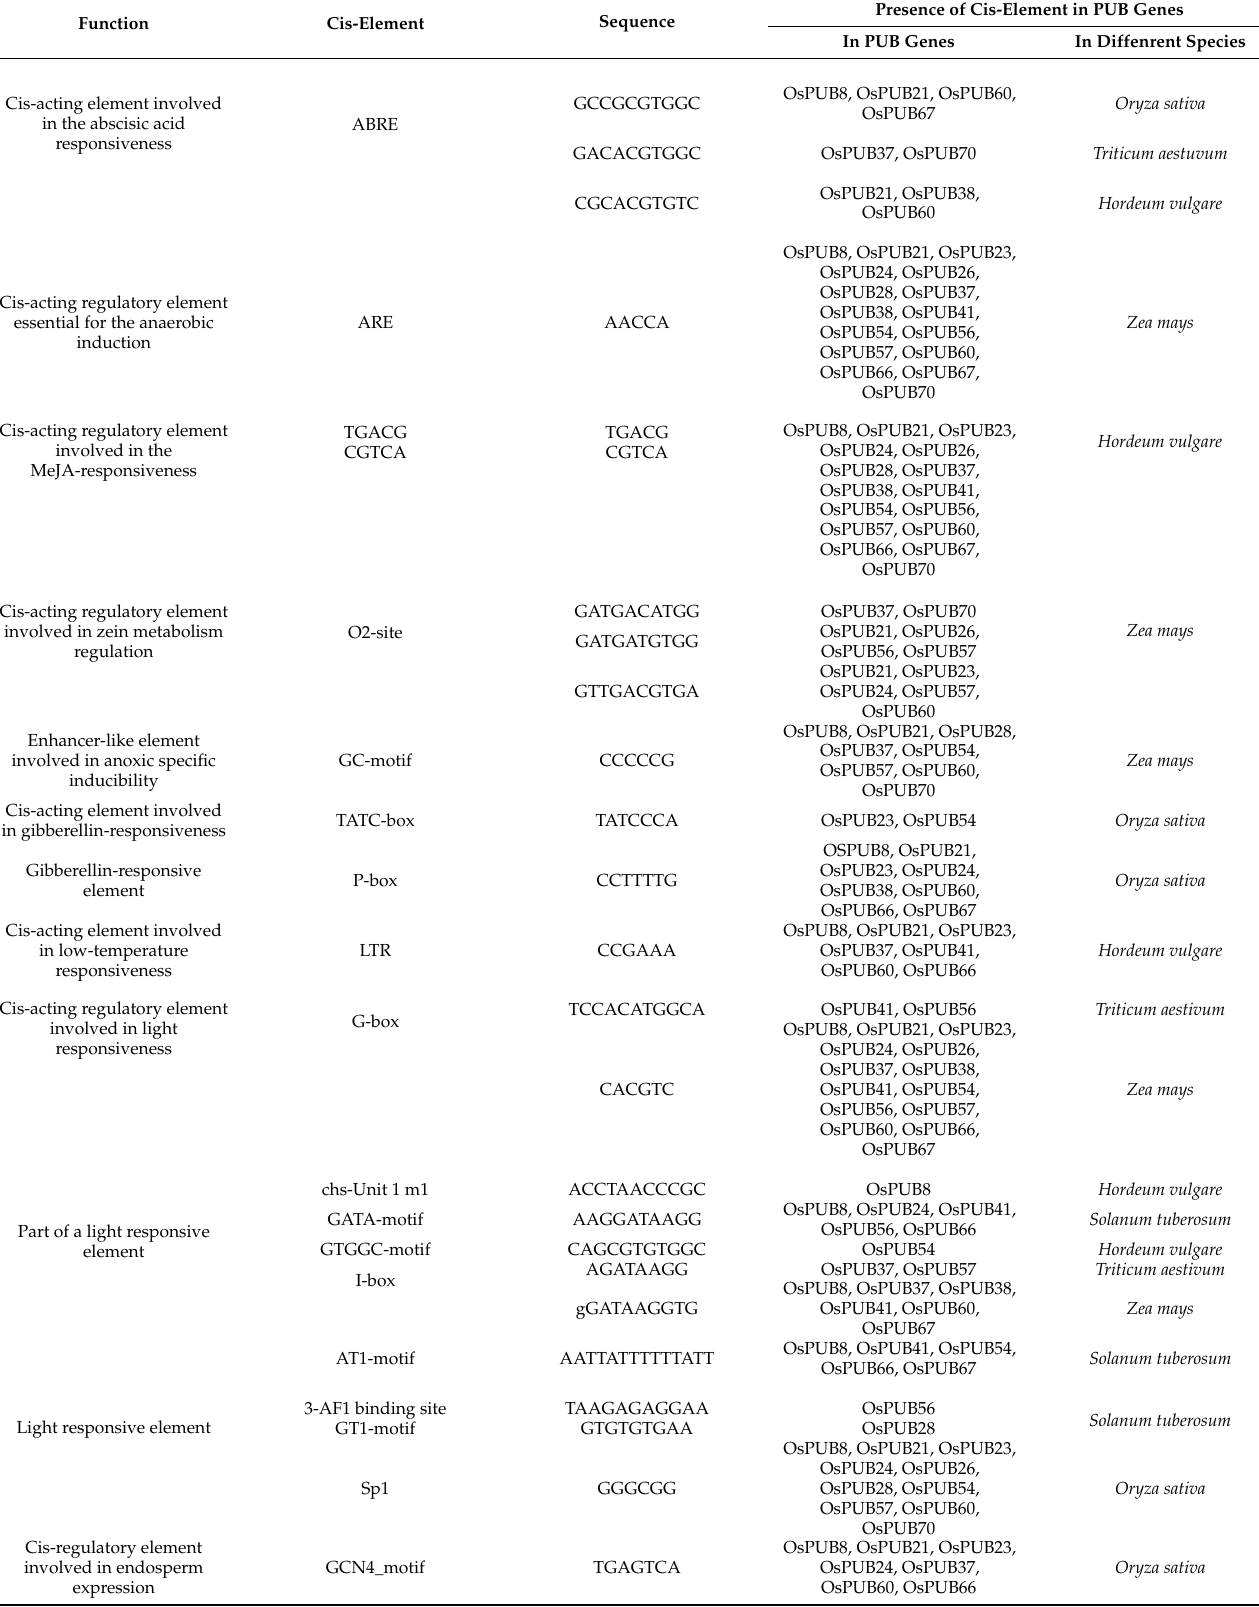
Table 2. Category of cis-elements extracted from 3000 bp upstream region of OsPUB genes using